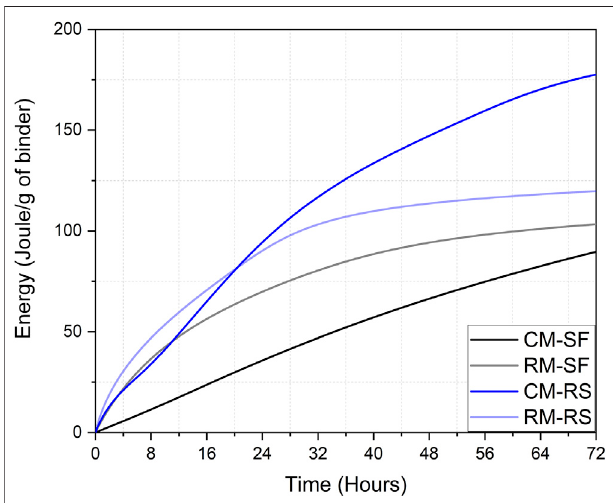
FIGURE 2 | Energy released on hydration (J/100 g of binder).